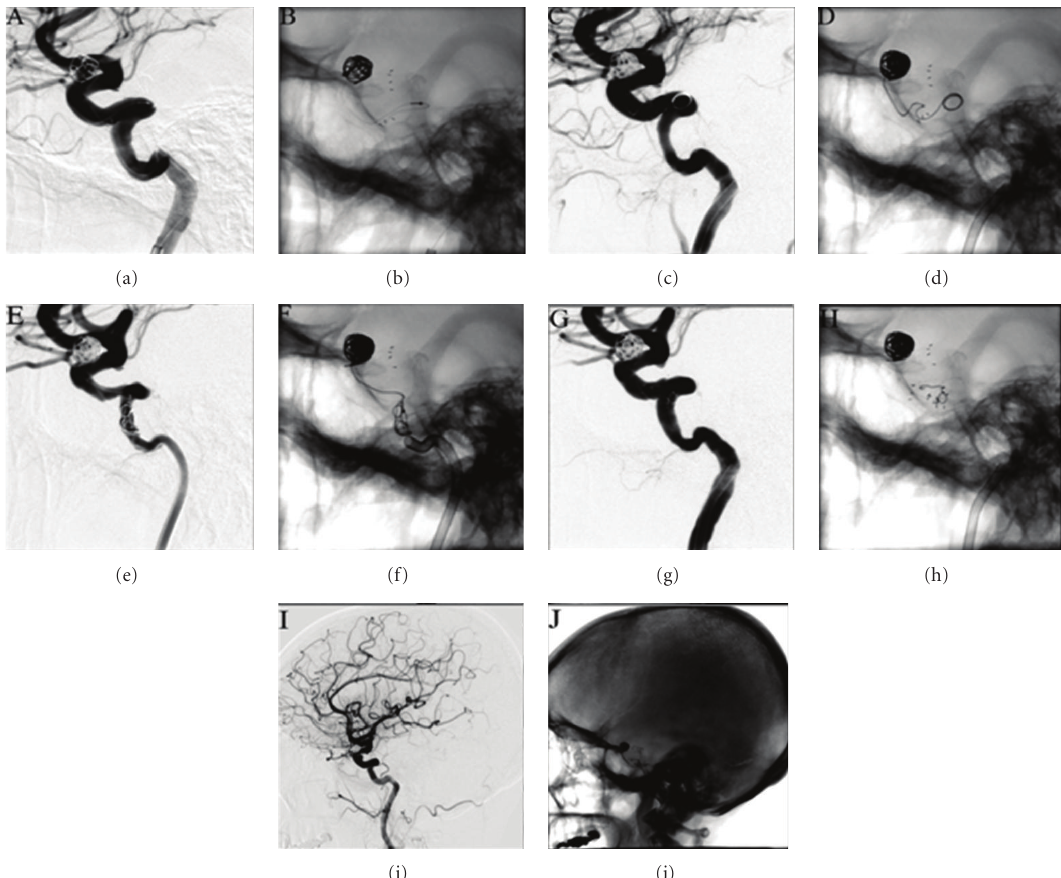
Figure 1: (a) and (b) Left carotid artery injection, lateral view; and plain X-ray. The stent was placed across the aneurysm neck and initial coil embolization performed. (c)–(f) During further coil embolization, the coil detached from the delivery catheter without activating the release mechanism. Manipulation and attempts to retrieve the misplaced coil with the Alligator and Microsnare device resulted in further coil herniation. (g) and (h) Left carotid artery injection, lateral view, and plain X-ray demonstrate that the misplaced coil was removed by the Merci device; a small fragment is left in the cavernous ICA and jailed to the wall with a second stent. (i) and (j) Angiogram and plain X-ray obtained after endovascular treatment show normal filling of the ICA and aneurysm